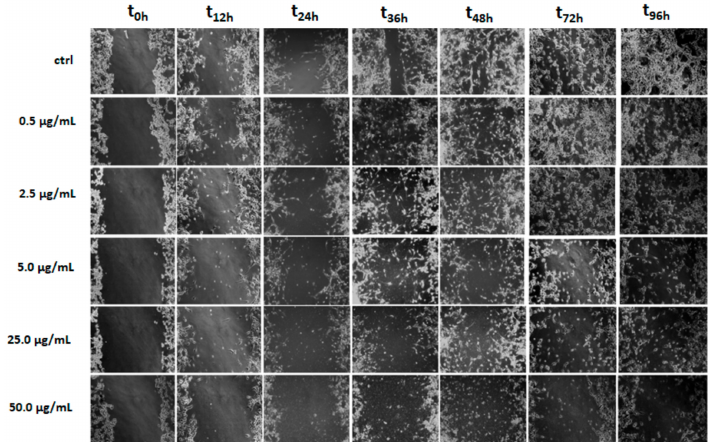
Figure 8. U-87 cells underwent a scraped wound and were then treated with di ff erent LnHS doses (0.5, 2.5, 5, 25 and 50 µ g / mL). Cells were photographed immediately following the scratch (0 h), after 12, 24, 36, 48, 72 and 96 h. Untreated cells (ctrl), were used as a control. Representative figures are shown from one of two independent